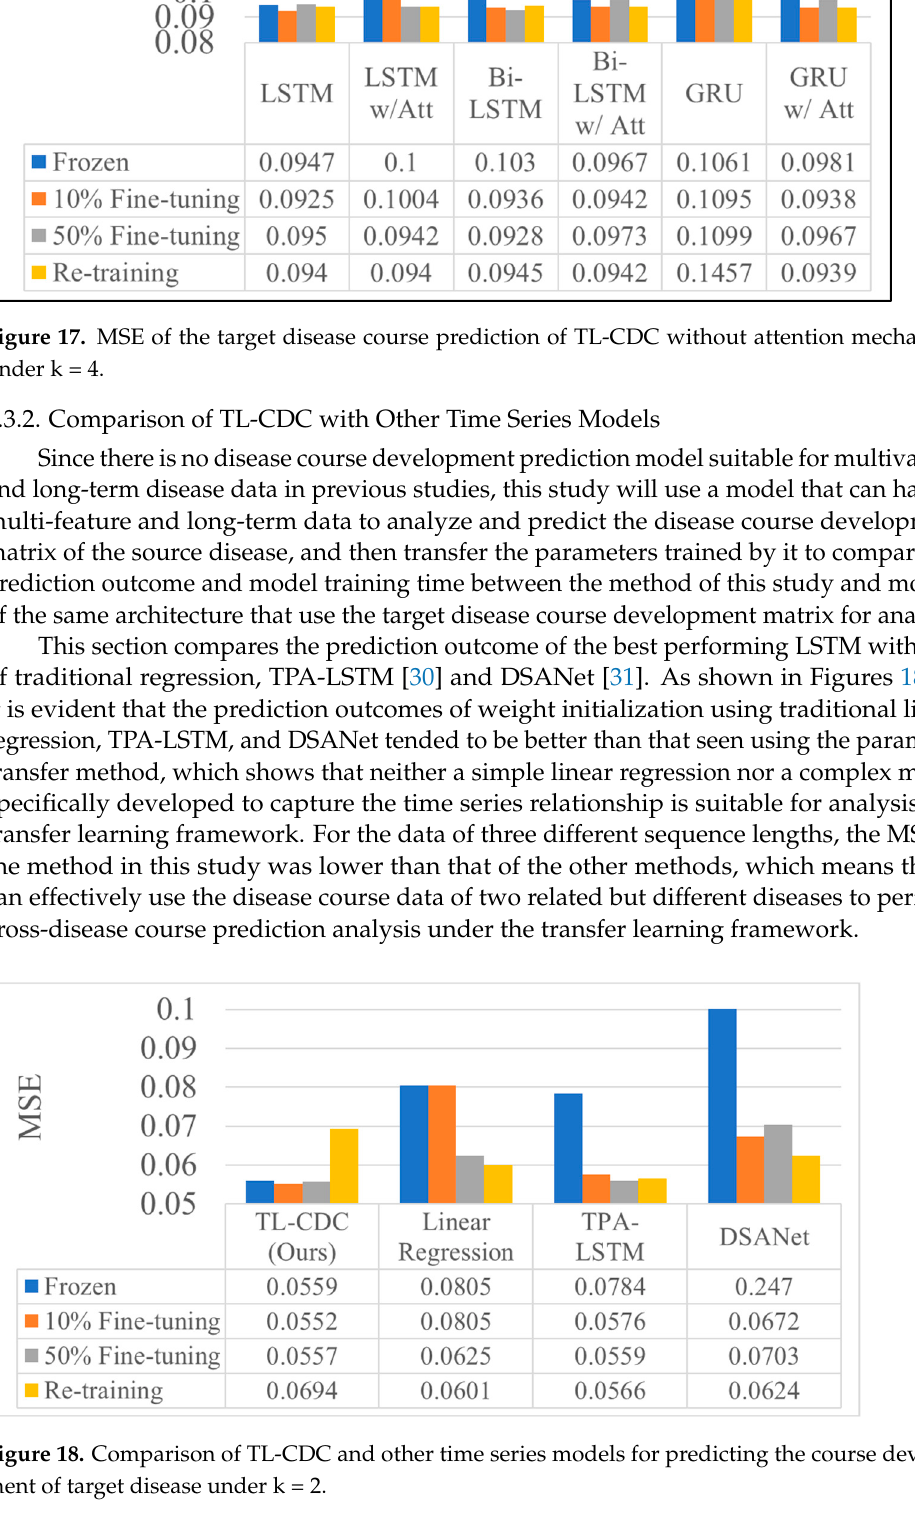
Figure 19. Comparison of TL-CDC and other time series models for predicting the course develop- ment of target disease under k = 3.